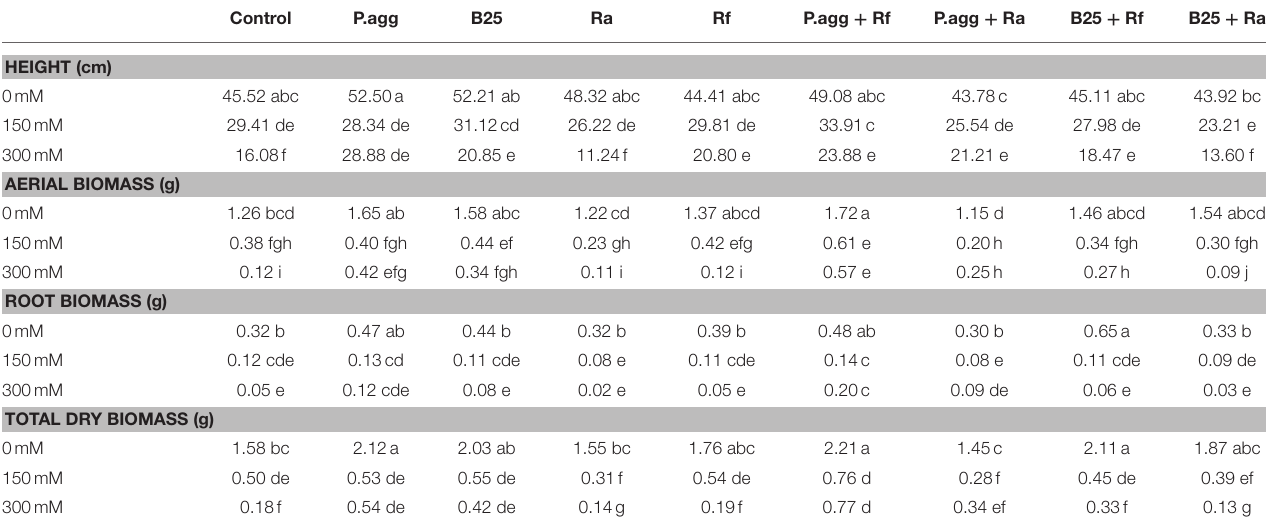
TABLE 2 | Effect of inoculation with PGPR and/or AMF on height, shoot biomass, root biomass and total dry biomass of C. obesa plants under salt stress conditions. Control